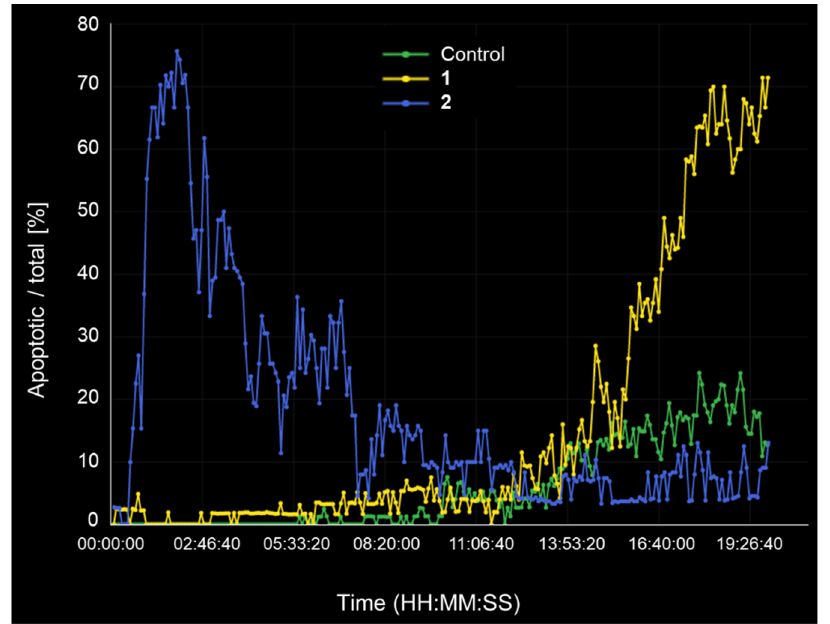
Figure 9. Label ‐ free continuous live ‐ cell imaging study on HeLa cells. Apoptosis kinetics obtained Figure 9. Label-free continuous live-cell imaging study on HeLa cells. Apoptosis kinetics obtained with LCDA software based on refractive indexes resulting from CX ‐ A observation over time. Total with LCDA software based on refractive indexes resulting from CX-A observation over time. Total exposure time 20 h. Green: untreated cells. Yellow: 1 (80 μ M). Blue: 2 (50 μ M). exposure time 20 h. Green: untreated cells. Yellow: 1 (80 µ M). Blue: 2 (50 µ